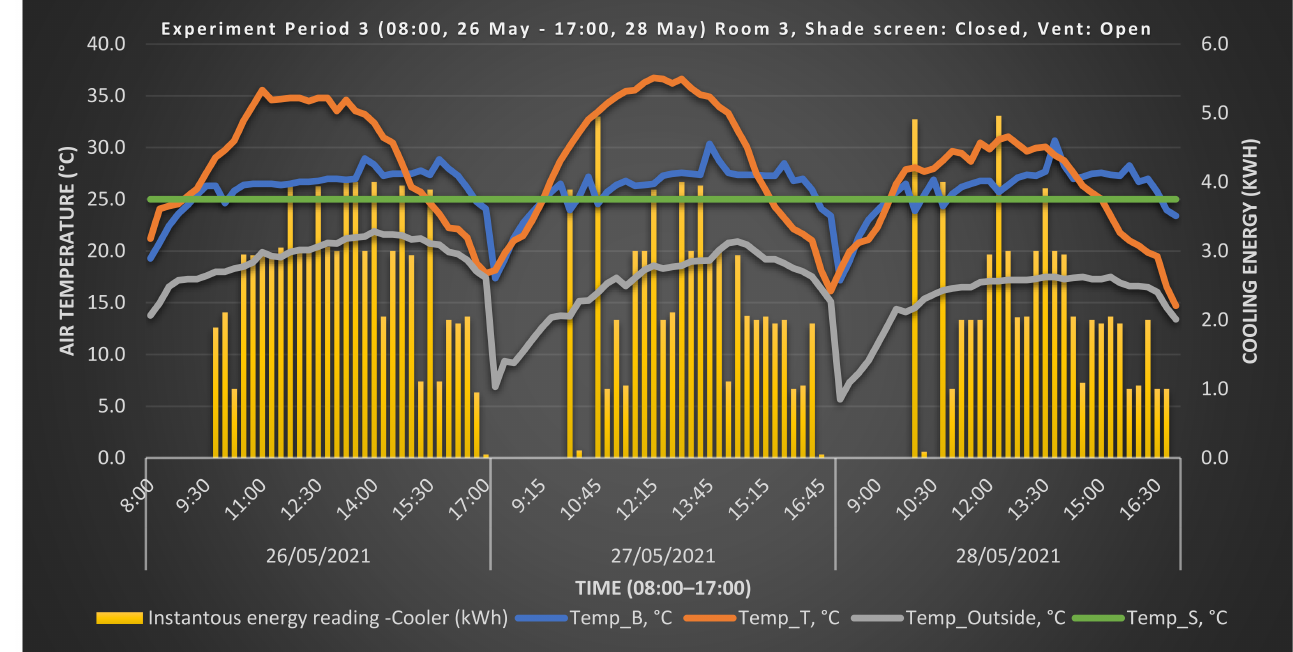
Figure 4. Temperature and energy use in different vent and shade screen status in experimental Period 3. Air temperatures ( ◦ C) collected at the base (B), top (T), and outside are depicted in blue, orange, and white lines respectively. Energy use (kWh) measured by mechanical coolers is dpeicted over time using yellow bars along with air temperatures.